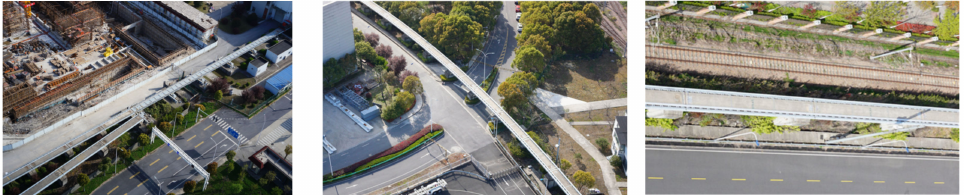
Figure 8. UAV images of the physical structure of the magnetic levitation track grider: ( a ) Turnout structure; ( b ) Turning structure; ( c ) Linear